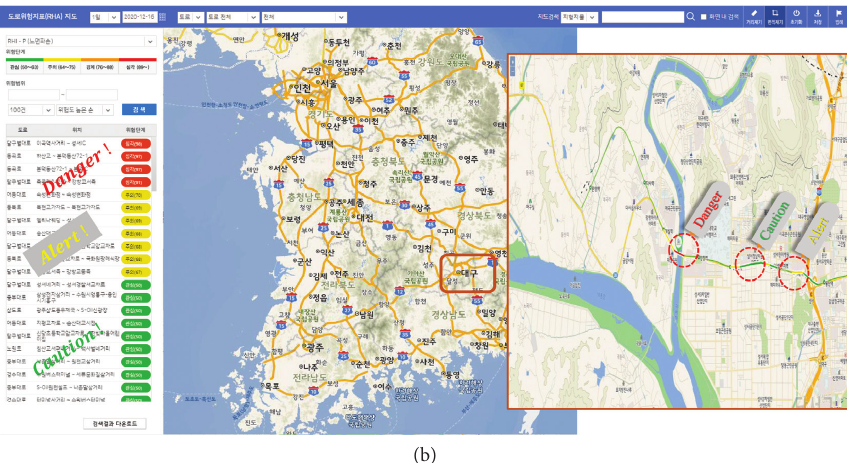
Figure 7: Road hazard index results in Daegu. (a) Road hazard index results in text format. (b) Road hazard index results in GIS